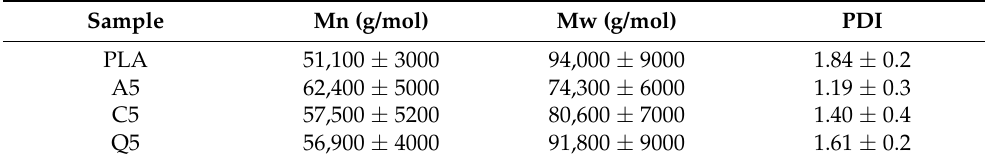
Figure 21. GPC elugram of melt-electrospun fiber webs formed of pure PLA or PLA composites containing 5% ( w / w ) of alizarin (A5), curcumin (C5), or quercetin (Q5). Table 6. The average molecular weight and PDI values of melt-electrospun fiber webs formed of pure PLA or PLA composites containing 5% ( w / w ) of alizarin (A5), curcumin (C5), or quercetin (Q5).